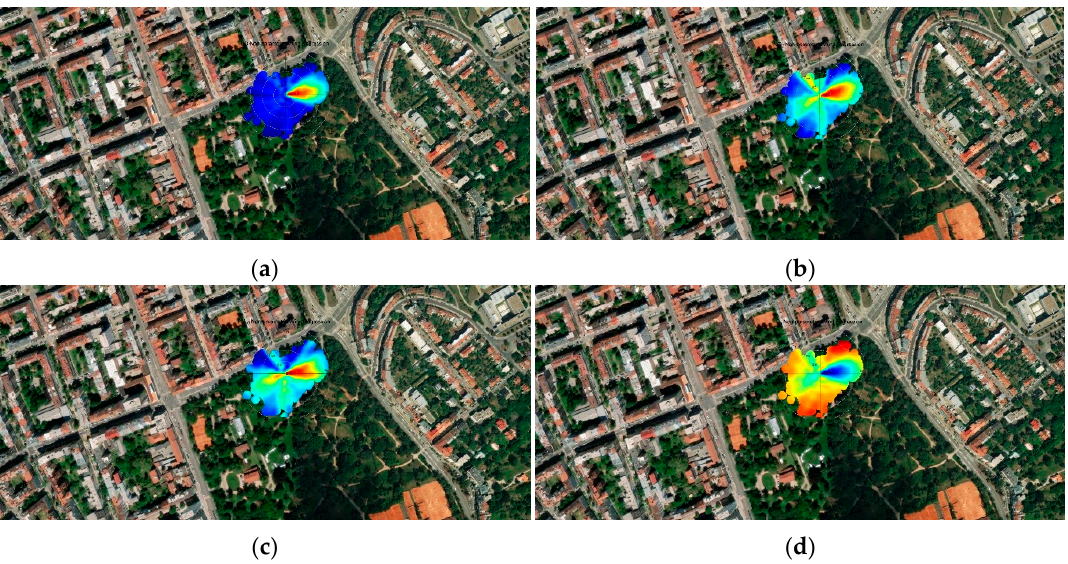
Figure 16. The NO ( a ), NO 2 (b ), PM 10 ( c ), and O 3 ( d ) concentration relationships to the wind speed and direction at Lužánky SS; sampling started on 22.8.2019 7:00.